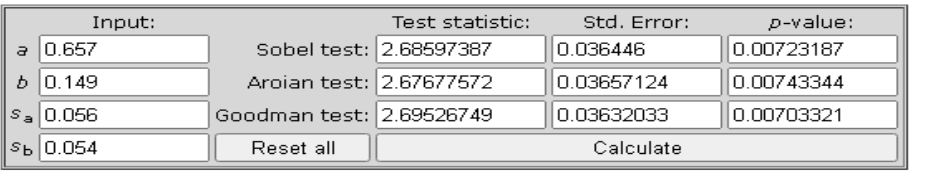
Source: primary data processed, 2020.